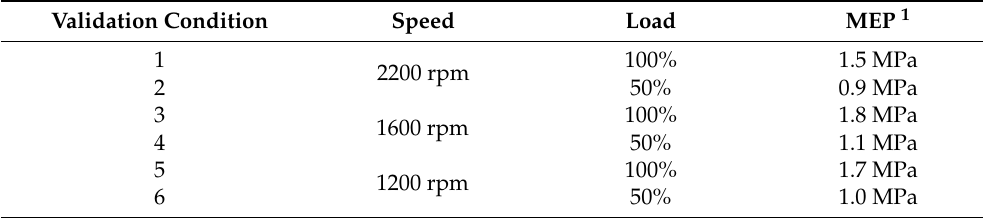
Table 4. Engine conditions for validation